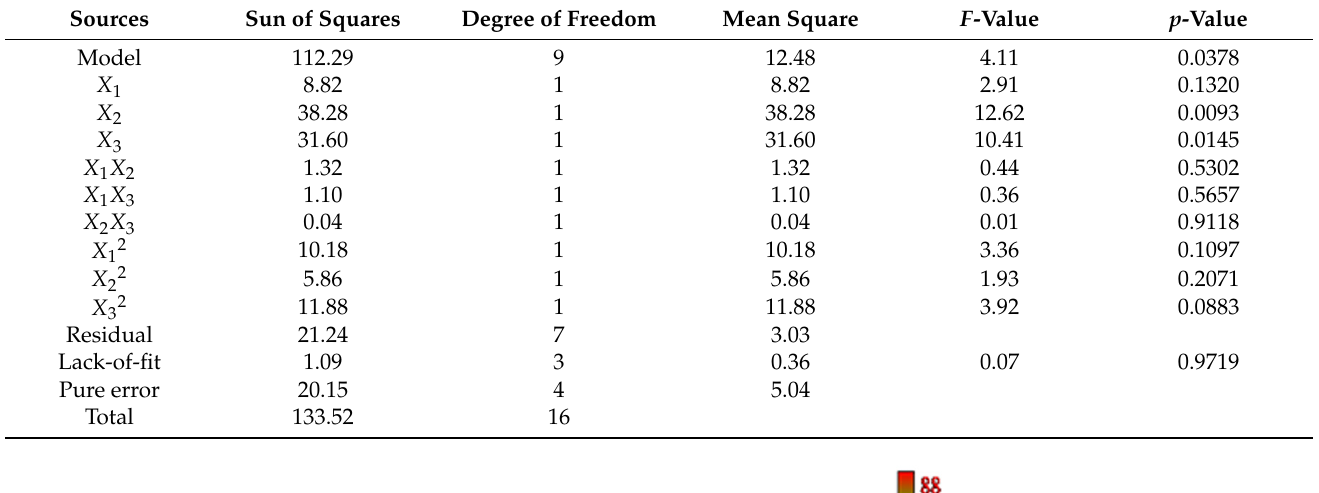
Table 7. ANOVA of the damage rate of unripe fruit.